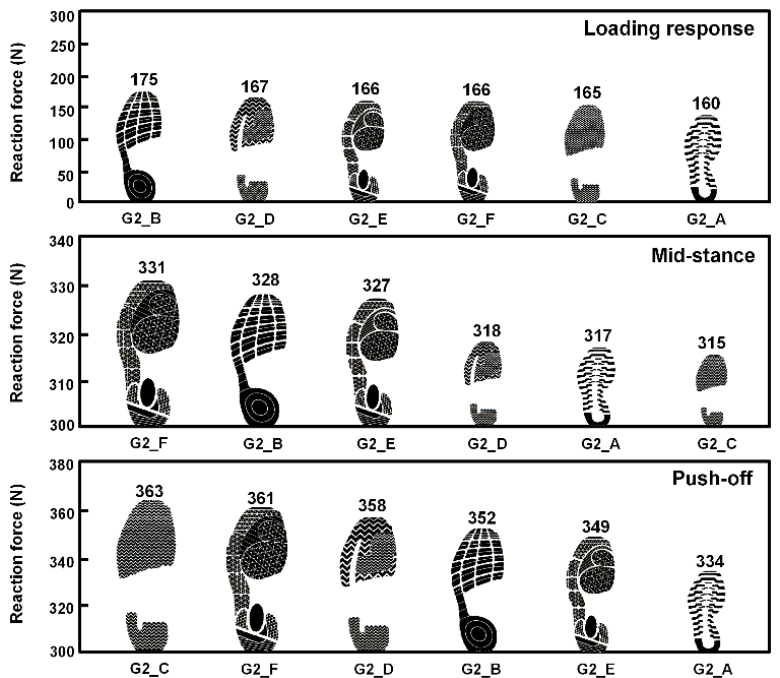
Figure 8. The reaction force chart for group two.